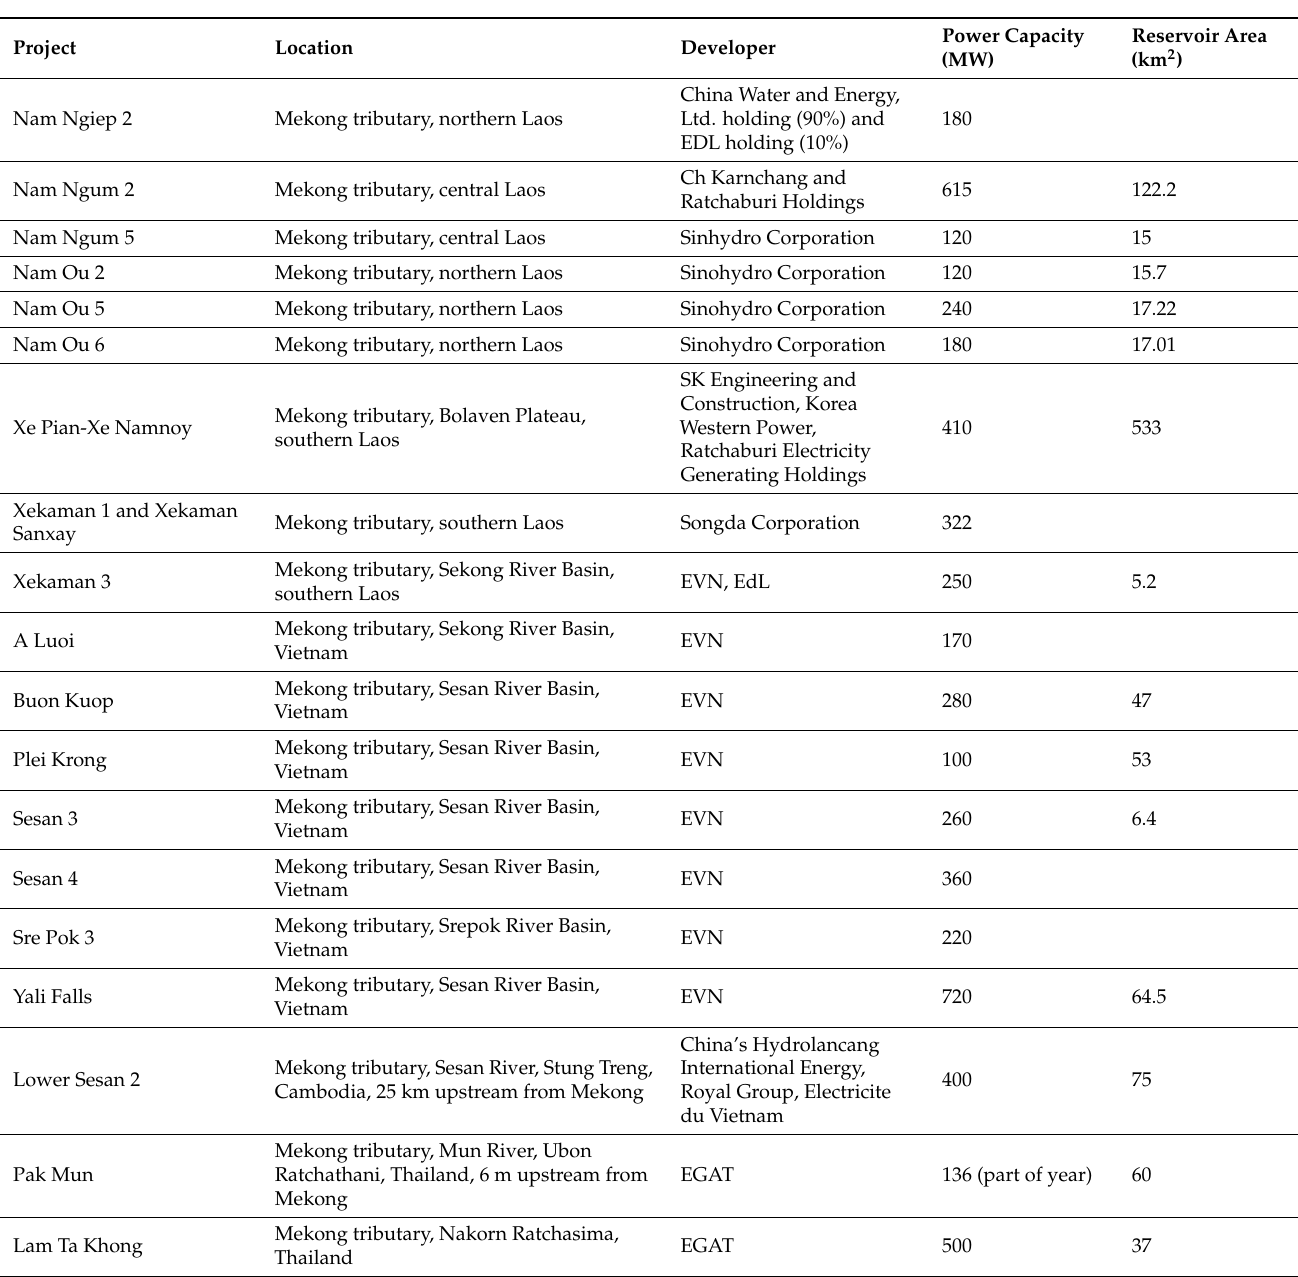
Figure 1 is a map of the hydropower dams in the Mekong River Basin that have an installed capacity of 100 MW or more (Figure